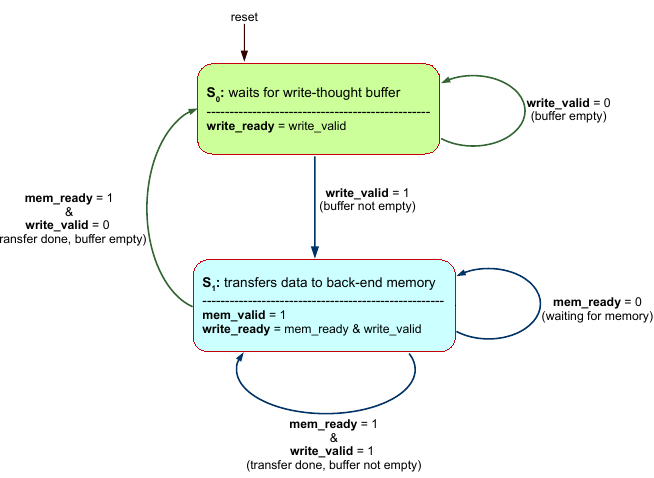
Figure 8. Back-End write-channel native